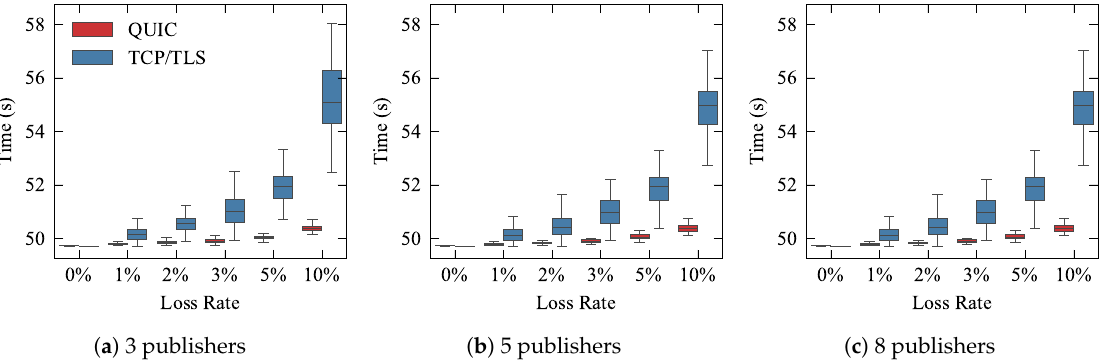
Figure 11. The performance of MQTT over QUIC and TCP/TLS in a shared channel with traffic pattern A. Finally, to validate the 0-RTT approach of QUIC, we ran the experiment for traffic pattern B, with eight publishers. This experiment was executed 50 times for each loss rate specified in Table 1, thereby ensuring statistically tight results. The results shown in Figure 12 evince that QUIC is able to reduce latency when a client resumes its connection with the server. It addition, when the channel conditions worsened, we can see that QUIC was able to yield much more predictable